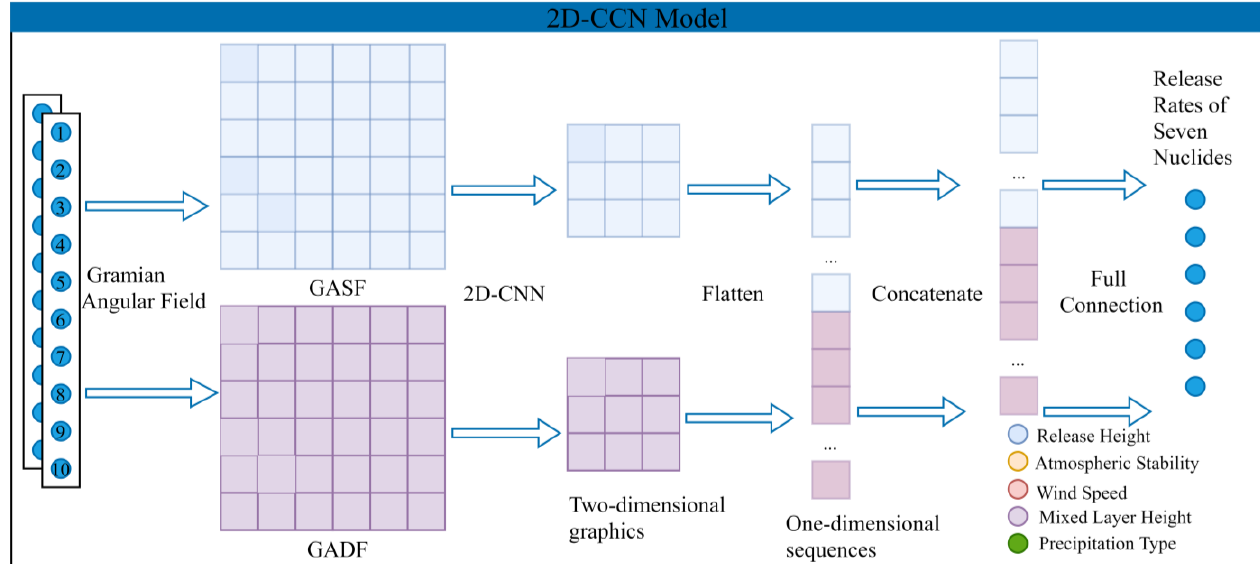
Figure 5. A multi-nuclide source term inversion model for nuclear accident based on a two-dimen- sional convolutional neural network (2D-CNN).